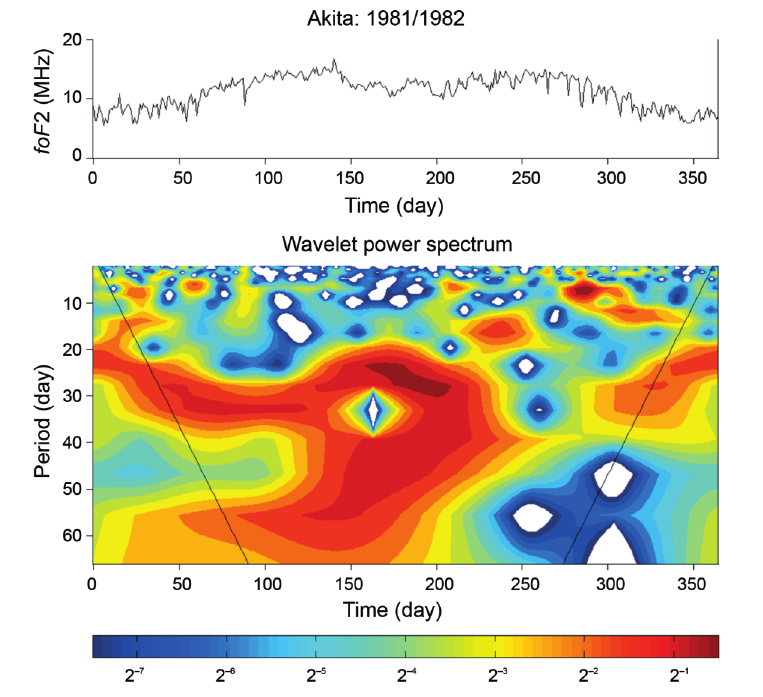
Fig. 1. Planetary wave type activity inferred from foF 2 for Akita, 1 July 1981-30 June 1982, Morlet wavelet transform. Top panel: time series of raw foF 2 data. Bottom panel: wavelet power spectrum of the planetary wave activity changing by colour from white and black-blue (minimum values) through green to red and black-red (maximum values). Wavelet power spectrum is normalized to